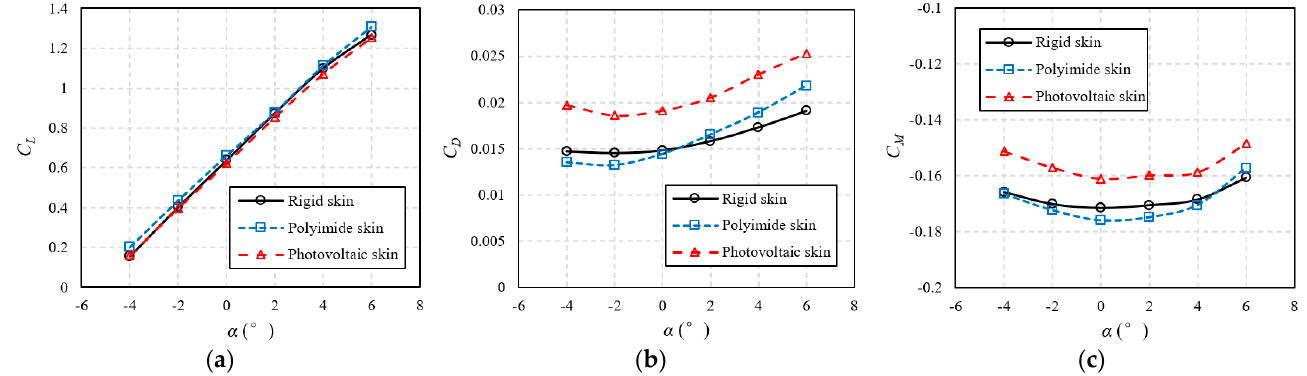
Figure 12. Aerodynamic characteristics of wings with three different skins ( v = 6.4 m/s): ( a ) C L - α ; ( b ) C D - α ; ( c ) C M - α .